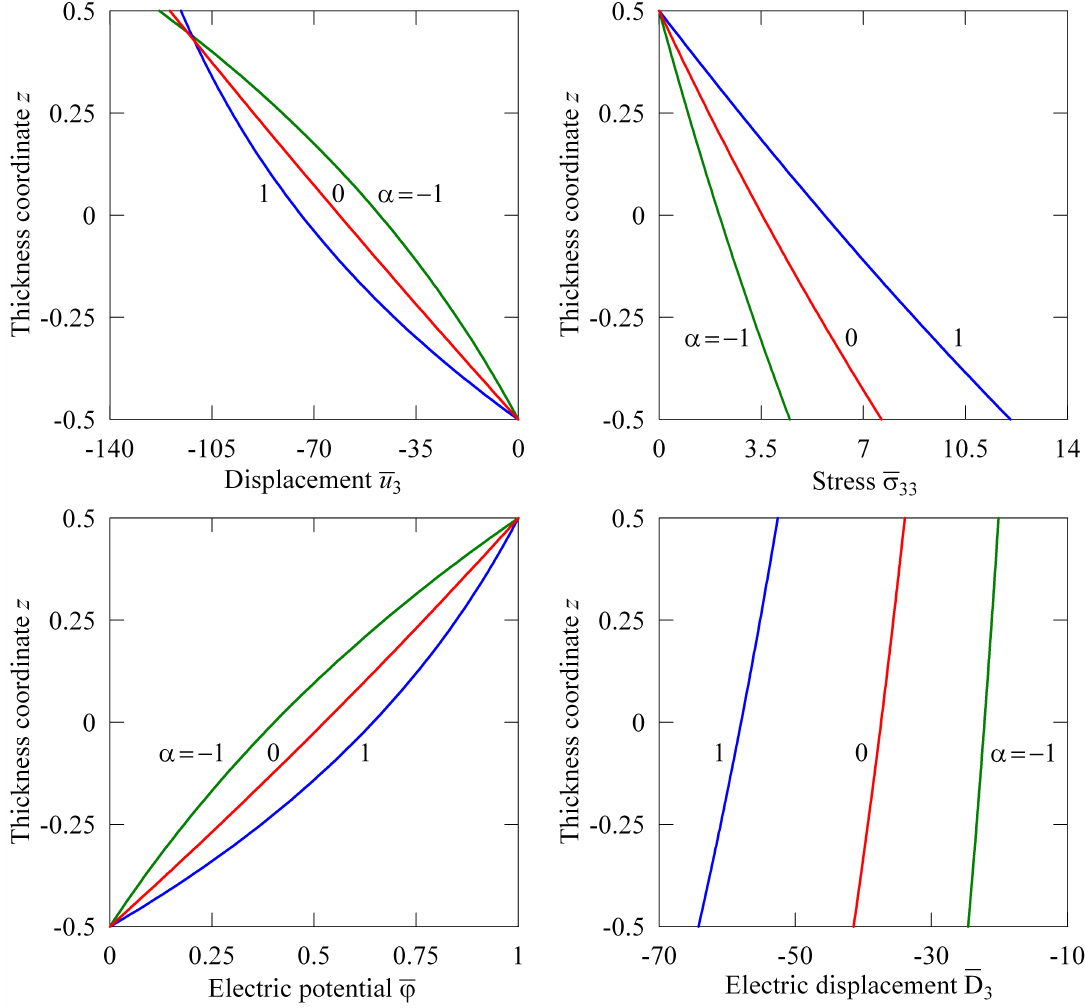
Figure 8: Through-thickness distributions of the displacement, stress, electric potential and electric displacement for a FGM piezoceramic sphere with R / h = 10 and N = 9 using 64 × 1